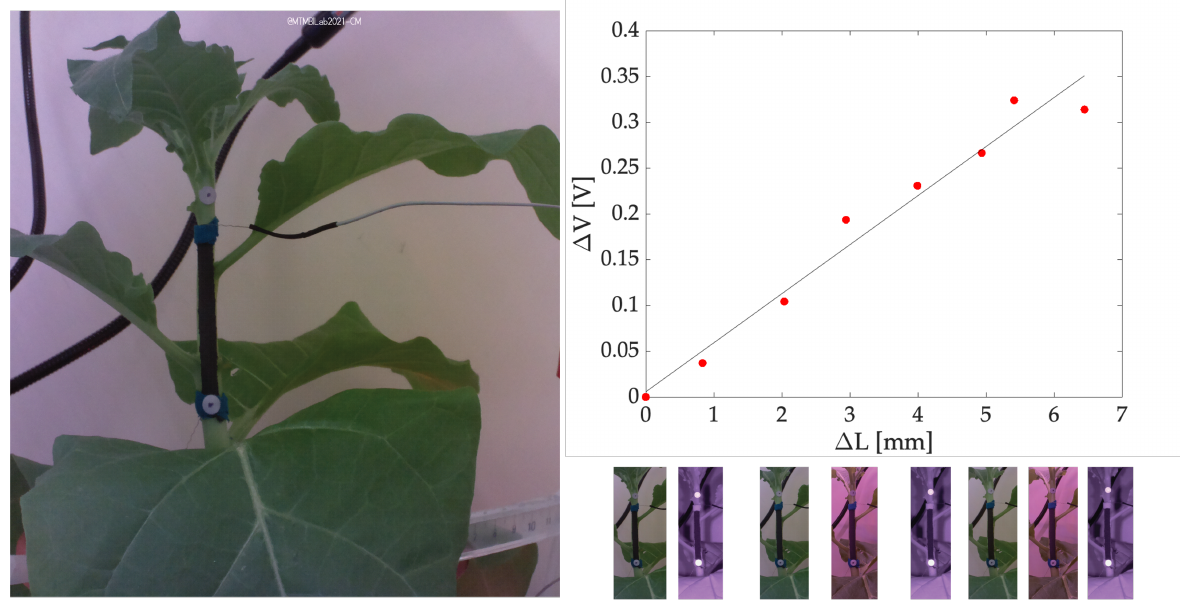
Figure 11. T and RH compensated output of the growth sensor plotted versus the stem growth measured by the reference camera. The best fitting line is also shown. Growth sample points have been collected every ∼ 8